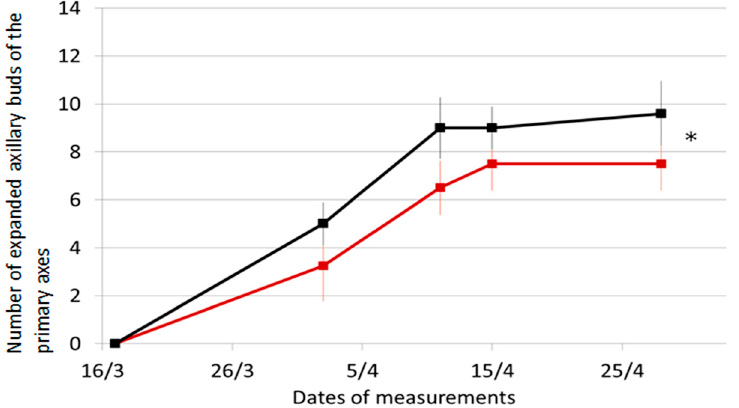
Figure 6. Evolution of the number of expanded primary axillary buds on Control—(black) and FR-plants—(brown). Vertical bars represent standard error of the mean with n = 4 or 5. Treatment effect * p < 0.0001, no interaction between treatment and dates of measurements was detected. The LightCue device was added on the 18 March.